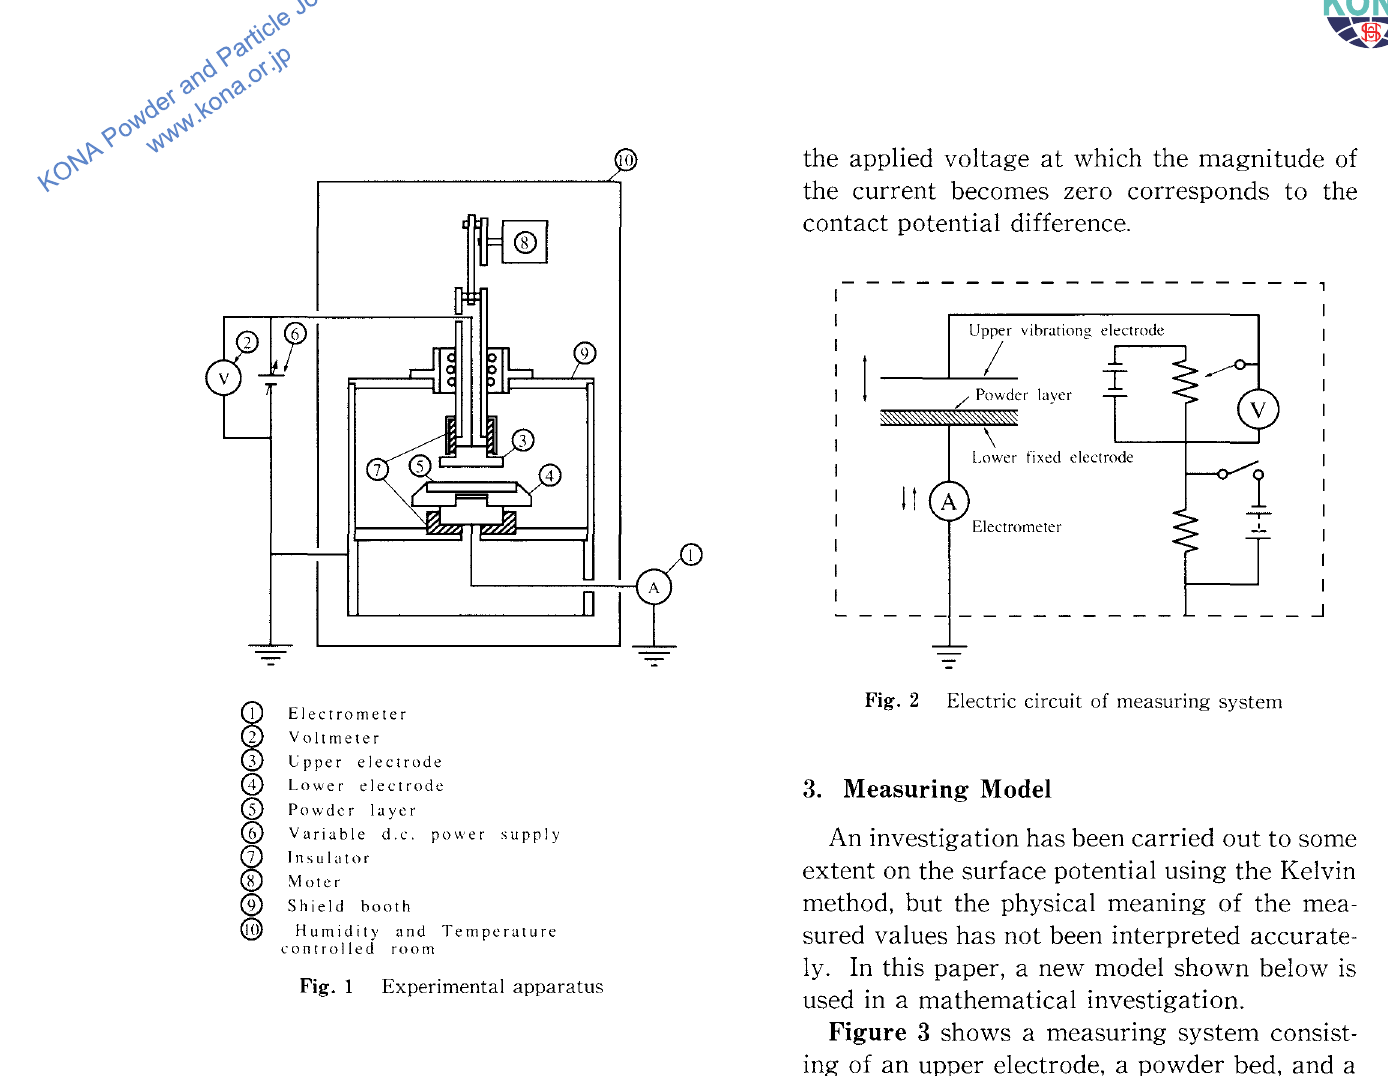
Fig. 1 Experimental apparatus